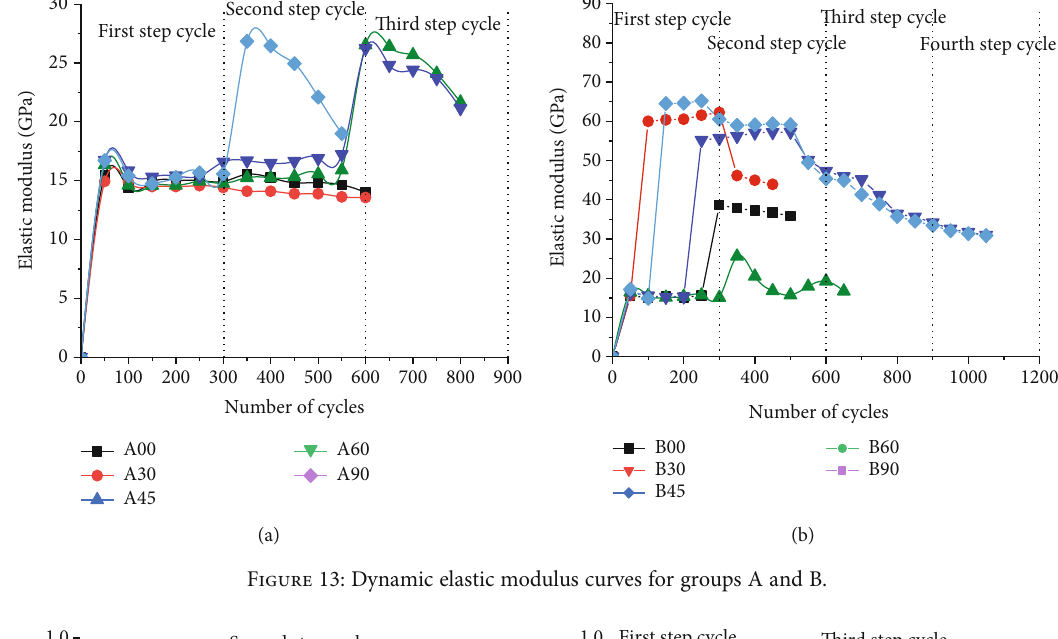
Figure 13: Dynamic elastic modulus curves for groups A and B.